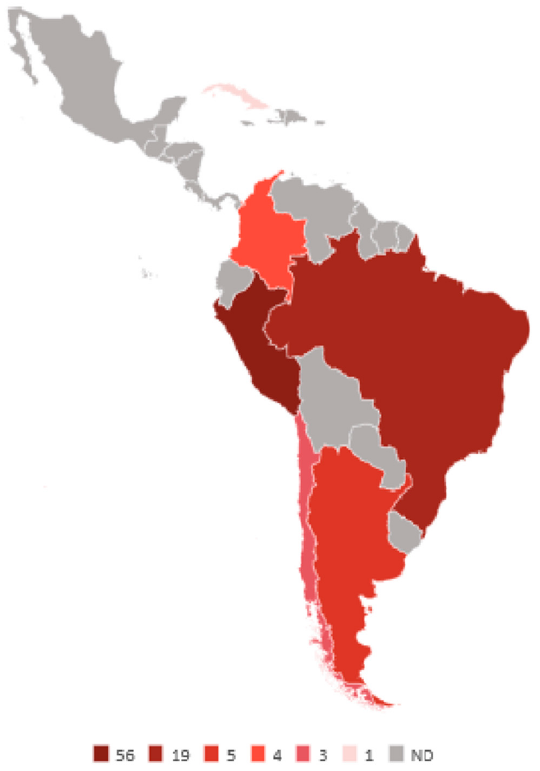
Figure 3. Kaposi sarcoma herpesvirus (KSHV) prevalence. Numeric values are in percentage. ND: not determined.